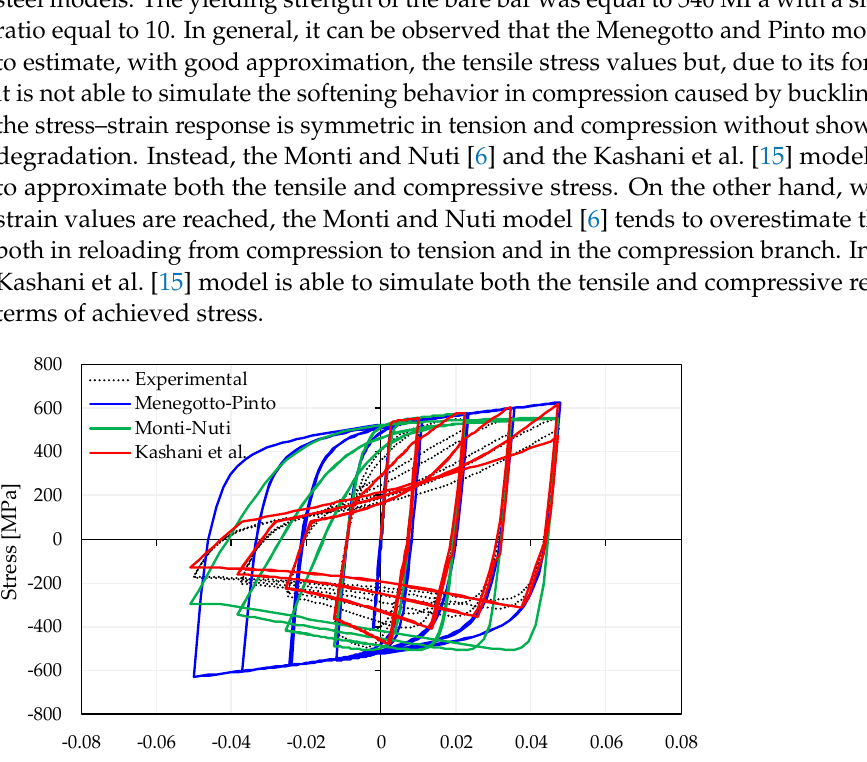
Figure 1. Constitutive law for steel including buckling: ( a ) Monti and Nuti model and ( b ) Kashani et al. model.